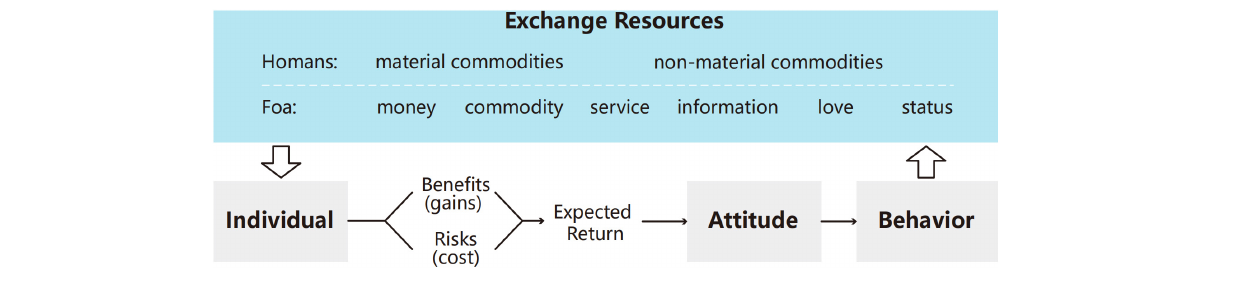
FIGURE 1 | Social exchange behavior and resource